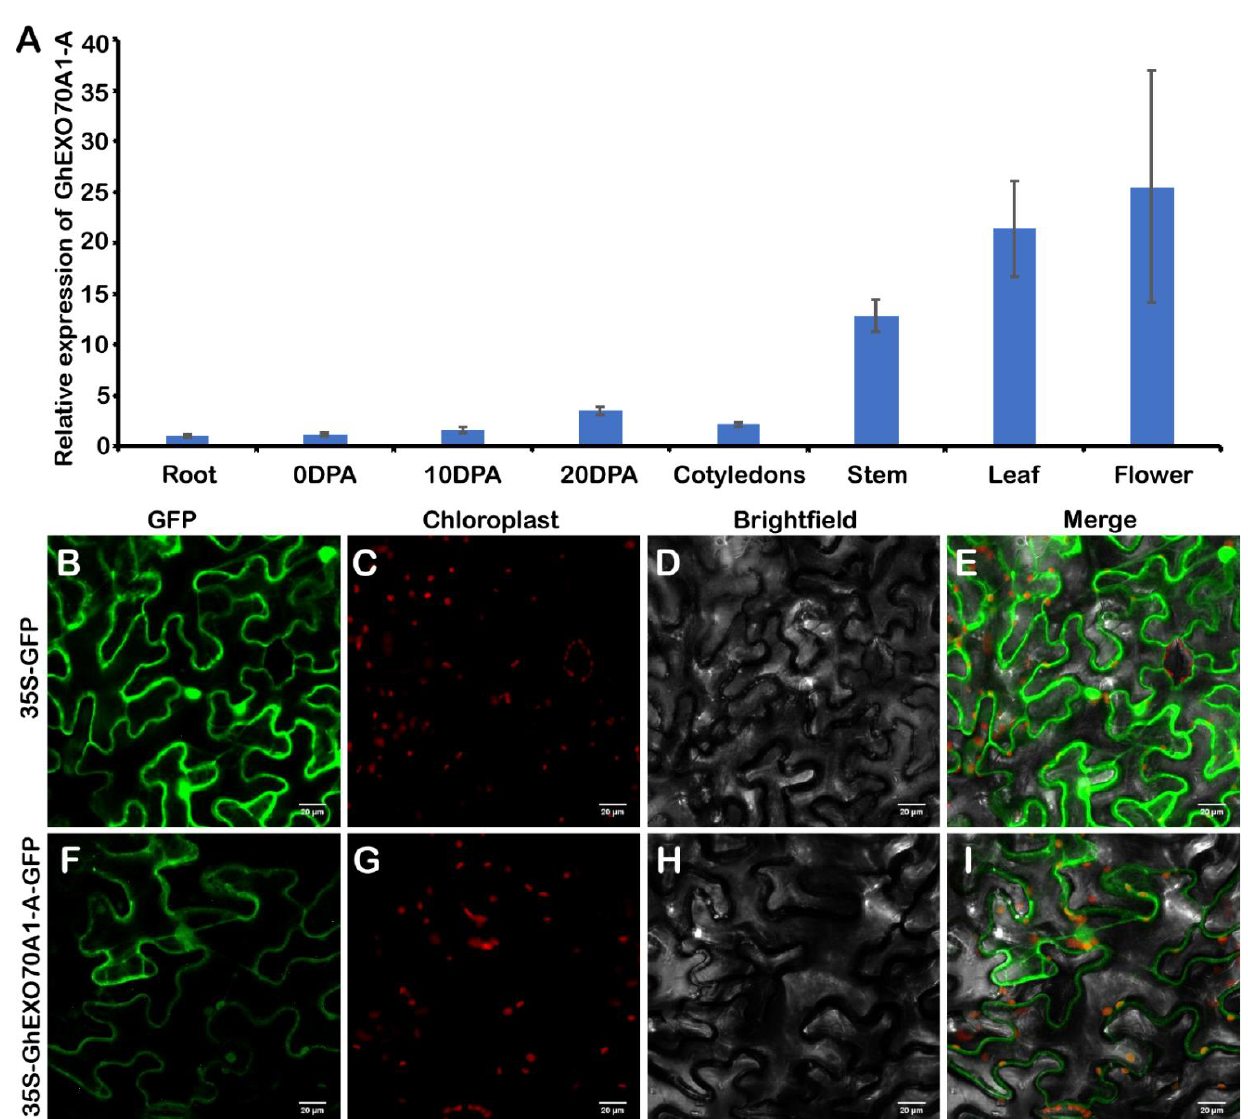
Figure 6. GhEXO70A1-A expression and subcellular localization analyses. ( A ) GhEXO70A1-A expression analyses in various upland cotton tissues. ( B – I ) Subcellular GhEXO70A1-A localization in tobacco. GFP: green fluorescence. Chloroplast: chloroplast spontaneous red fluorescence. Merge: green and red fluorescence and bright field fusion. ( B – E ): 35S-GFP empty vector as control. ( F – I ): 35S-GhEXO70A1-A-GFP vector located in plasma membrane. Bar: 10 µ m. Data are means ± SD for three